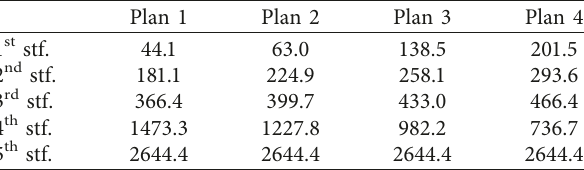
Figure 15: Schemes of DMF stiffness design. Table 6: Stiffness values of four schemes.